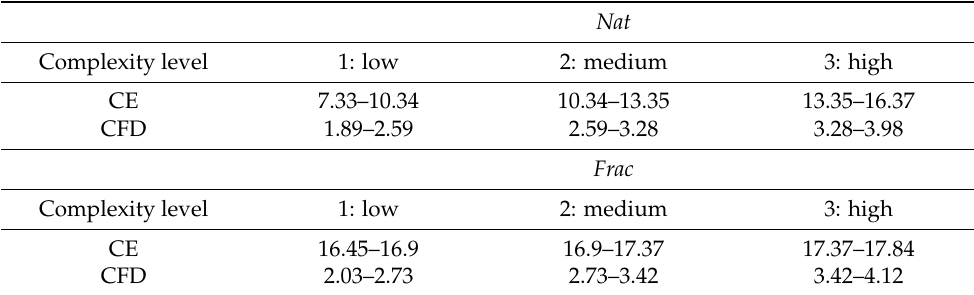
Table 2. CE and CFD levels for Nat and Frac images.